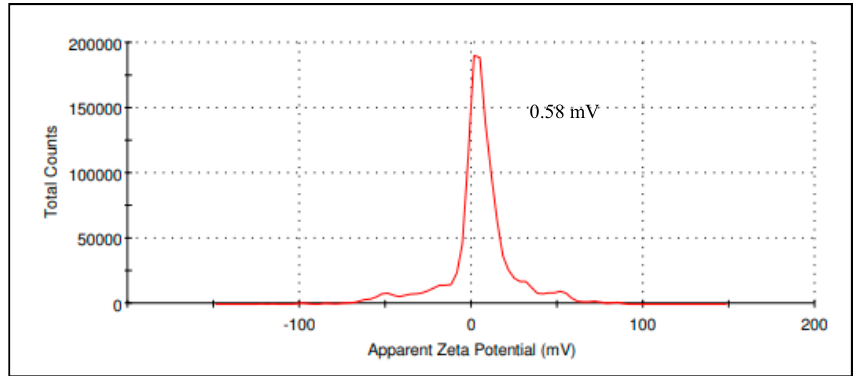
Figure 3. The zeta potential of Citral-loaded self nano-emulsifying drug delivery system (CIT-SNEDDS)